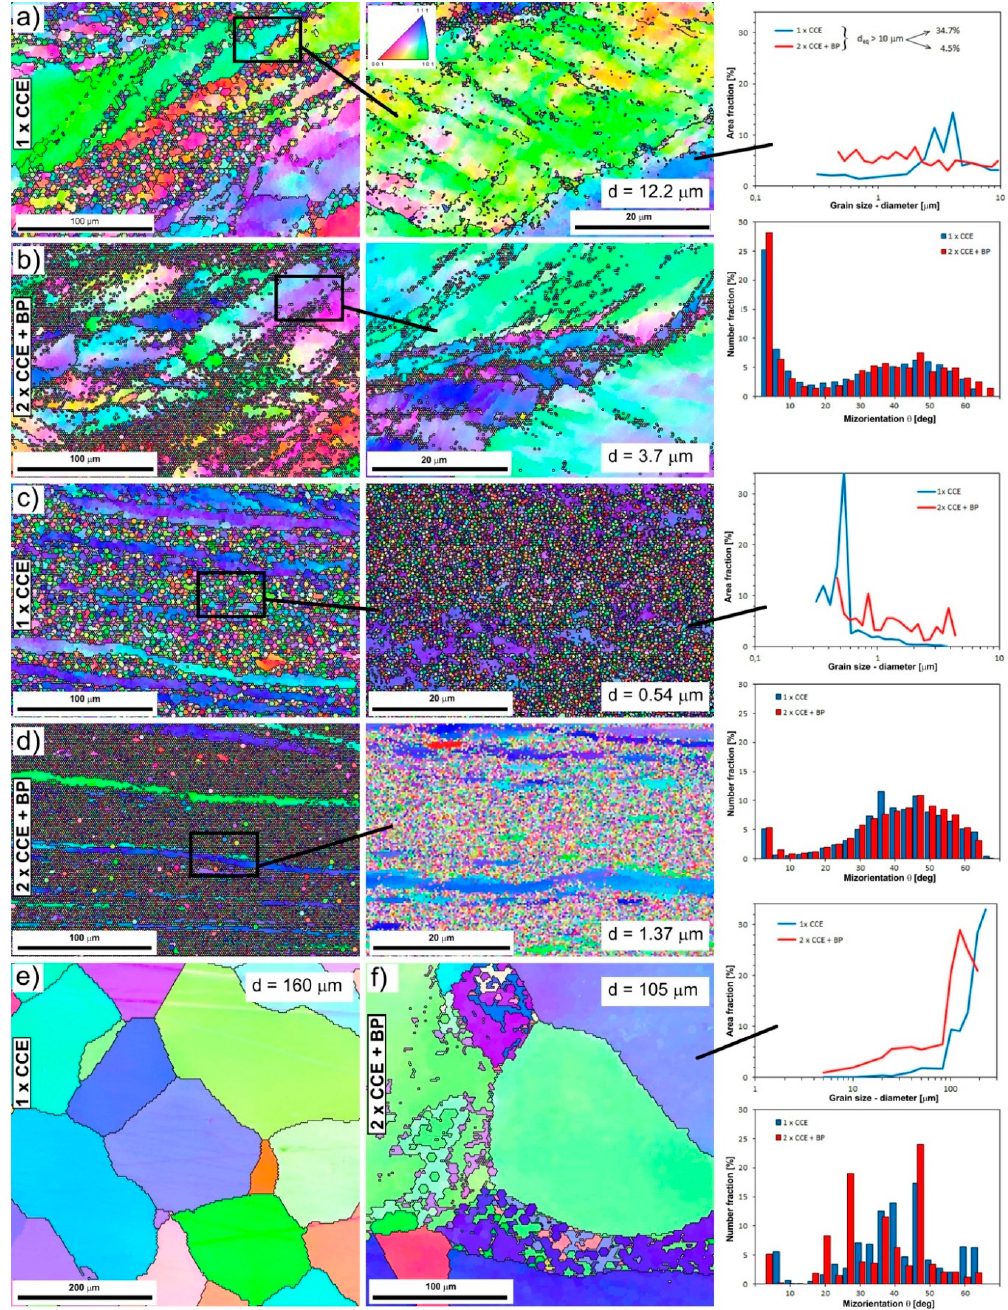
Figure 10. Electron backscatter diffraction system (EBSD) misorientation maps (OIM) obtained from samples subjected to CCE process with different areas (Figure 1b): ( a , b ) III-area of cutting, ( c , d ) IV-area of triaxial compression ( e , f ) V-area of blocked stresses, at one pass of CCE without BP and two passes with BP. Black lines of the colored areas outline correspond to the high-angular nature of grain boundaries (HAGB).